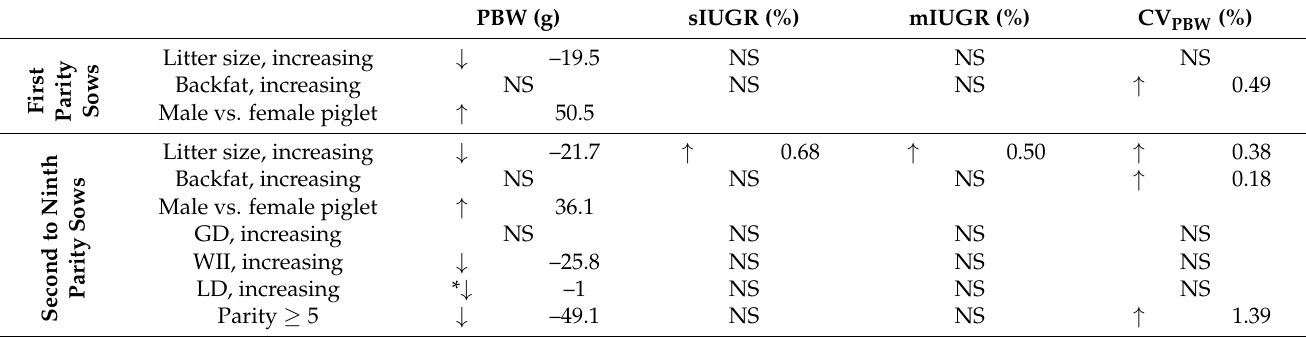
Table 3. Overview of the effects of tested risk factors apart from feed systems 1 .